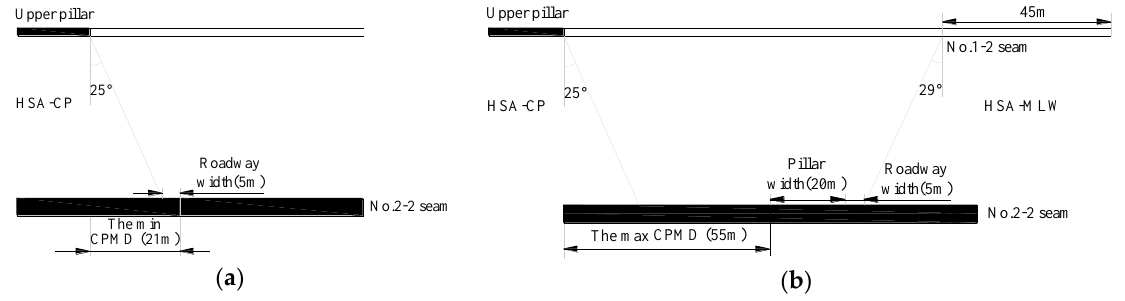
Figure 8. The rational CPMD: ( a ) The minimum CPMD, ( b ) the maximum CPMD.